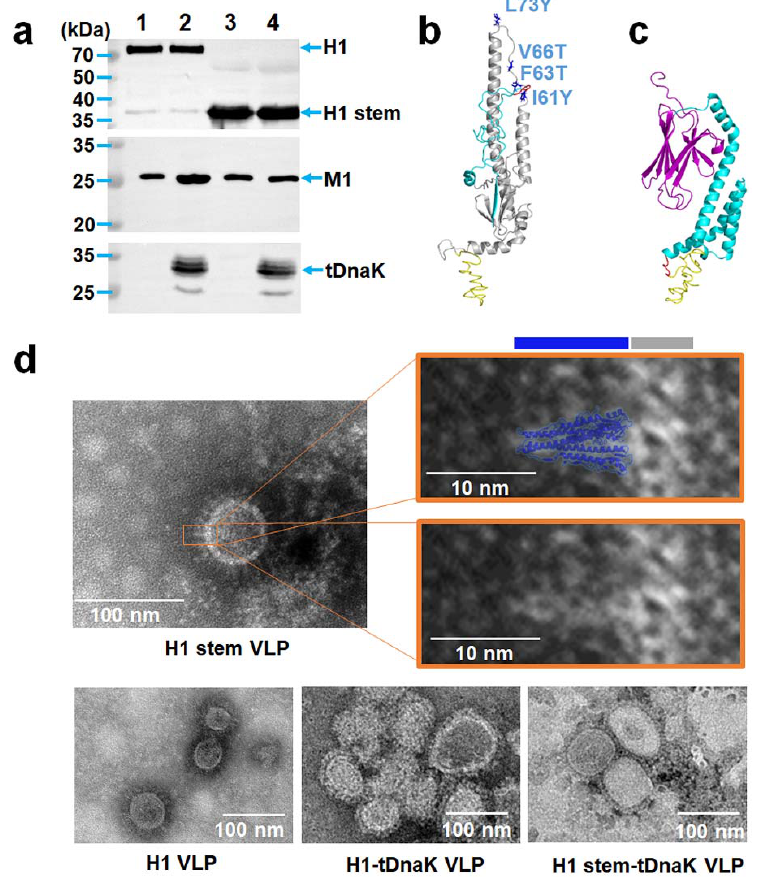
Figure 2. The characterization of the cVLPs. ( a ) Western blot analysis of the expressions of the full-length H1, H1 stem, M1, and tDnaK from the cVLPs, including (1) H1 VLPs, (2) H1-tDnaK VLPs, (3) H1 stem VLPs, and (4) H1 stem-tDnaK VLPs. The predicted structures of ( b ) the PR8 H1 stem and ( c ) tDnaK from E. coli . ( d ) Transmission electron microscope analysis of H1 stem VLP, H1 stem-tDnaK VLP, H1 VLP, or H1-tDnaK VLP. White bars represent 100 nm in the chimeric VLP images and 10 nm in the images of partial enlargement. The blue and grey bars above the right image indicate the lengths of the H1 stem domain and lipid layer. The cartoon of the H1 stem that was intercepted from the PR8 H1 structure (PDB: 1RU7) was generated using PyMOL software. The shape and size were compared by image overlay with TEM image and cartoon image. The height of the H1 stem in the cartoon measured by using PyMOL is approximately 10 nm.